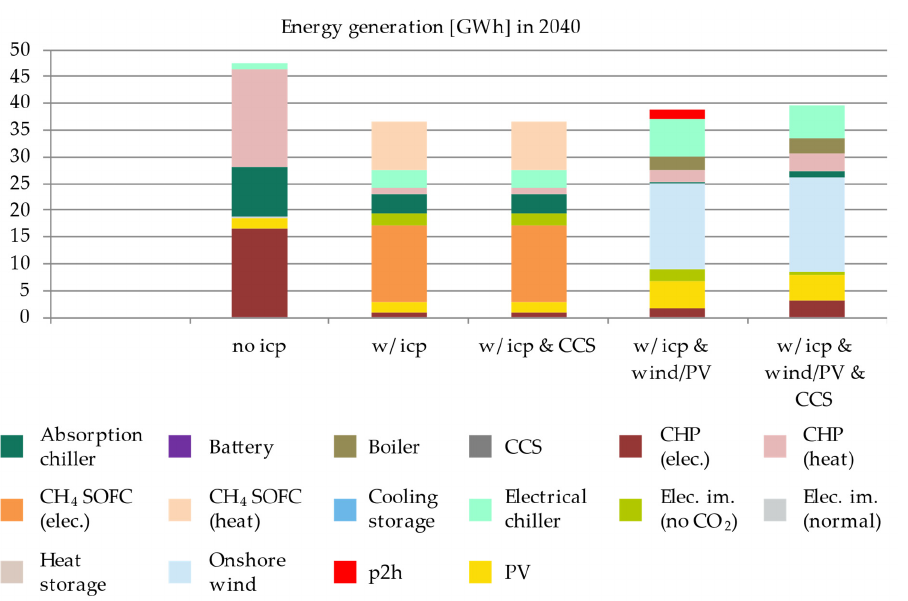
Figure 3. Installed capacities for the German scenarios in 2040.